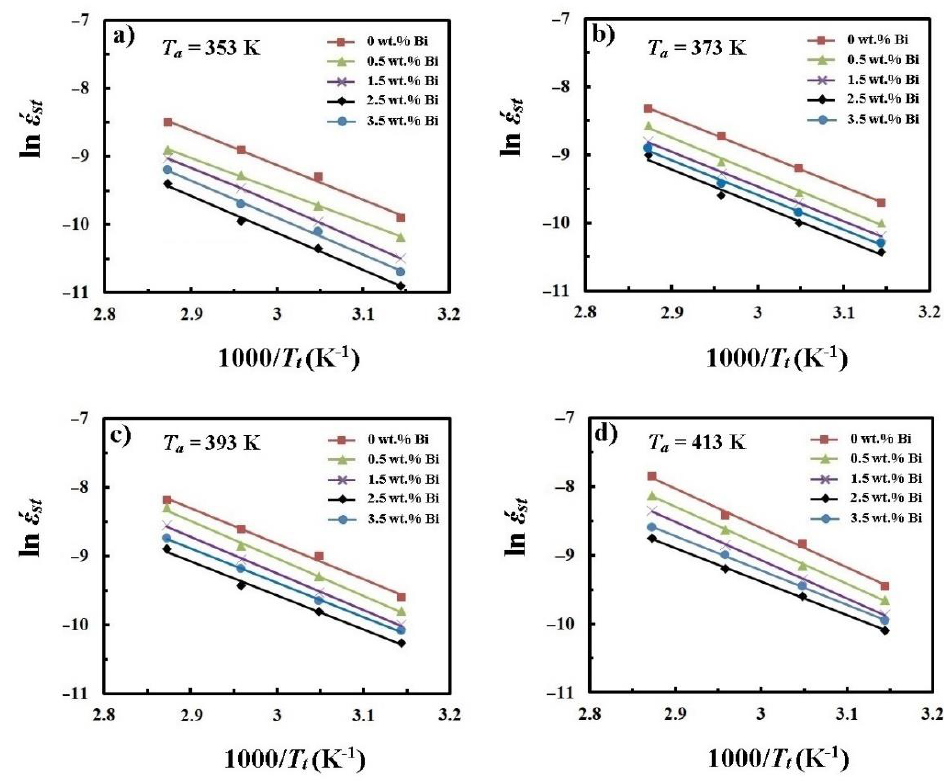
Figure 11. Relation between ln έ st and 10 3 / T t for different Bi contents. Aging temperatures, T a , applied are ( a ) 353, ( b ) 373, ( c ) 393, and ( d ) 413 K.